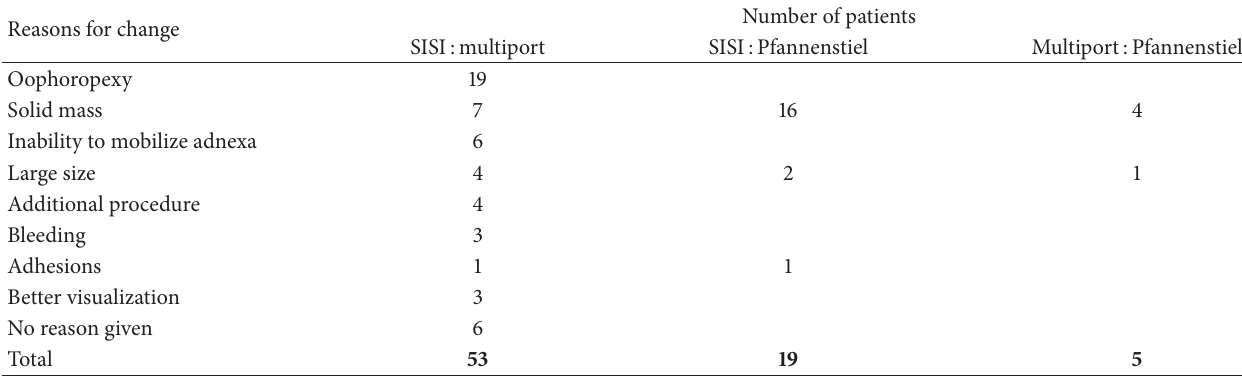
Table 2: Reason for change in approach, by initial approach.